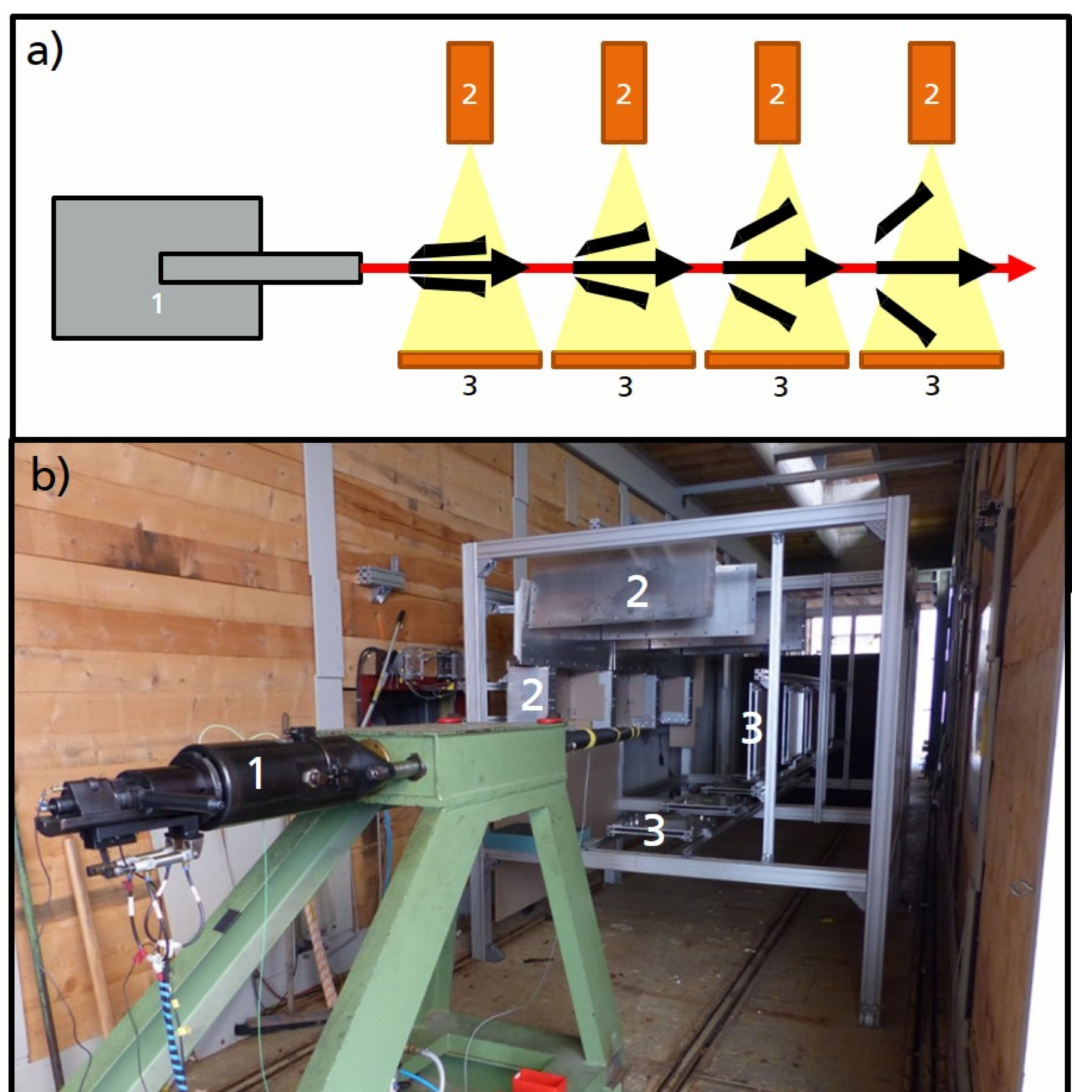
Figure 1. Experimental setup: accelerator—in this case, a 30 mm smooth bore cannon (1); flash X-ray tubes (2); and image plates (3). ( a ) Schematic drawing of the experimental setup showing the four imaging channels (consisting of one flash X-ray source and one detector each) of one of the two perpendicular viewing directions. ( b ) Photo of the setup. Only the X-ray tubes and image plates of position 1 are